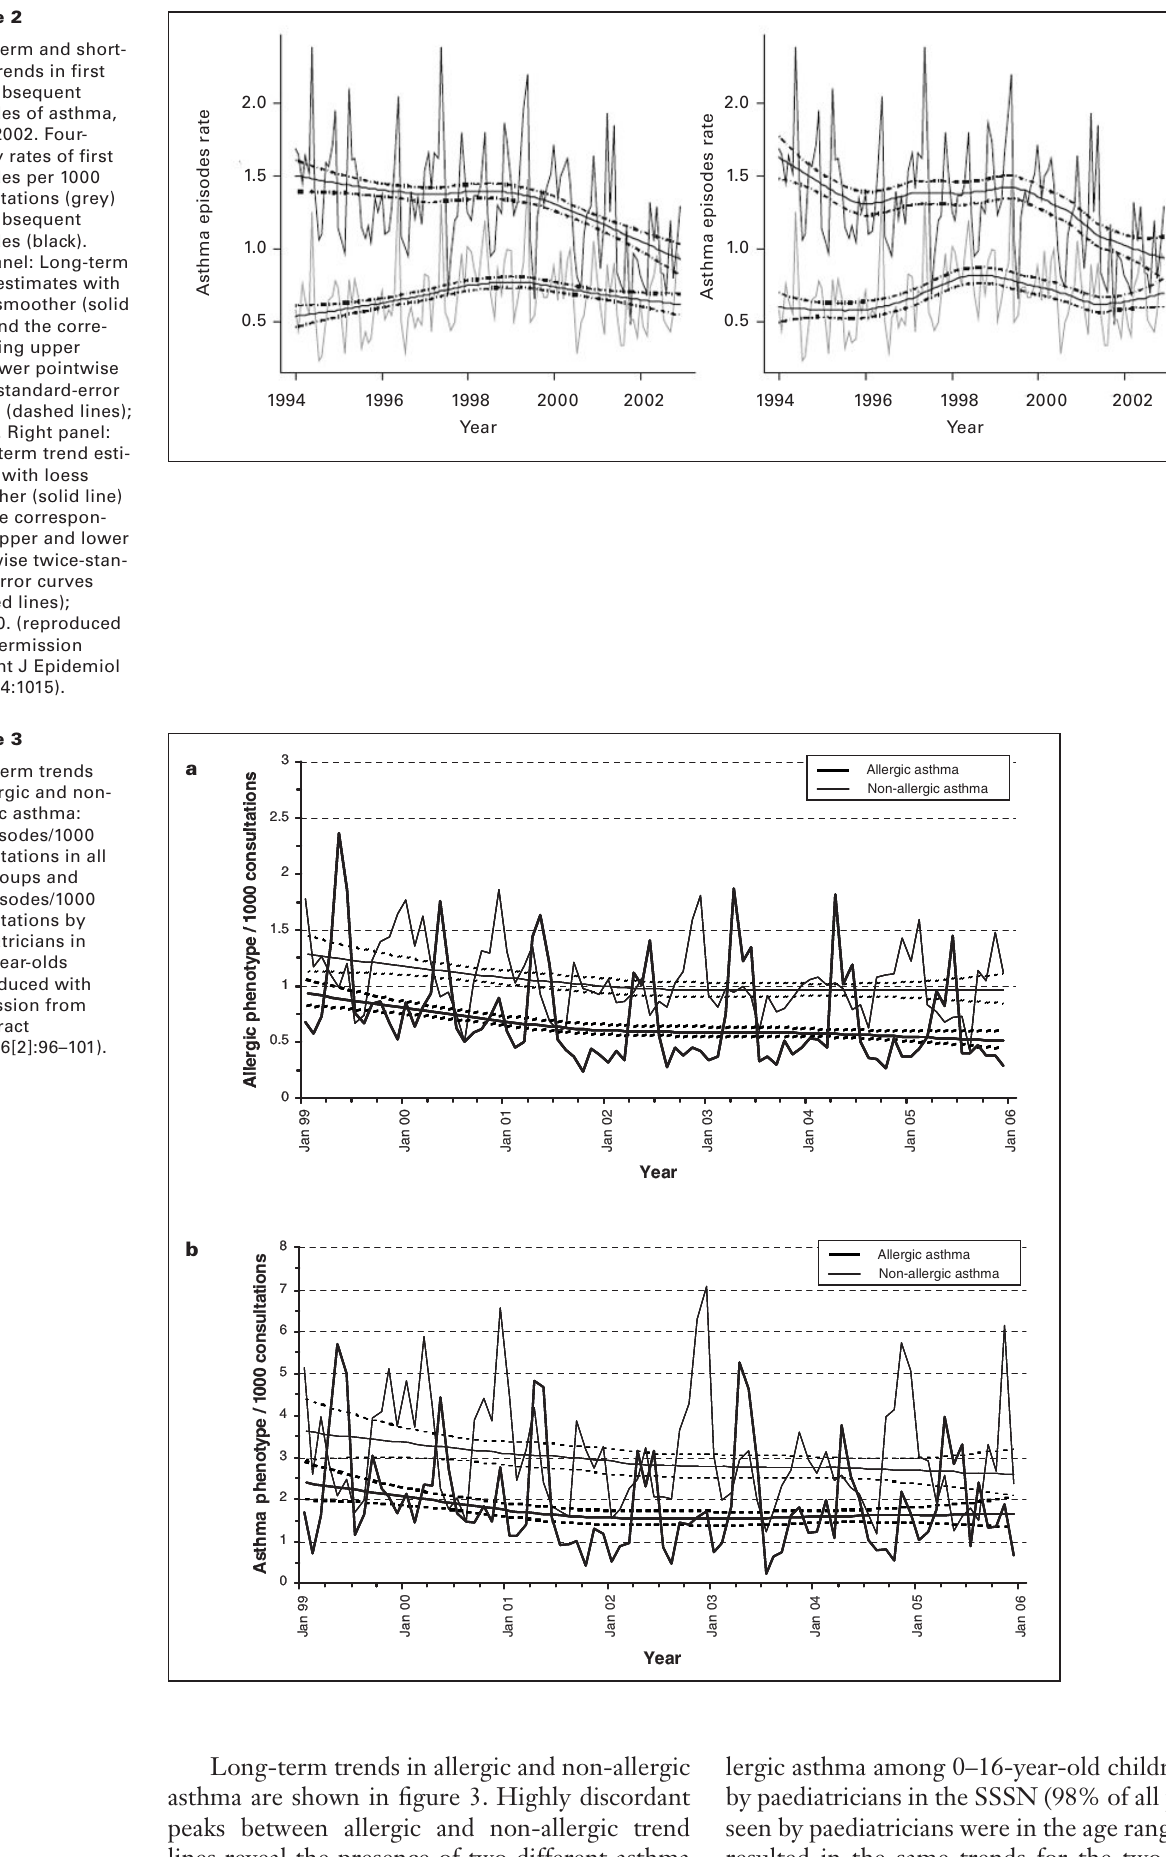
Allergic asthma Non-allergic asthma